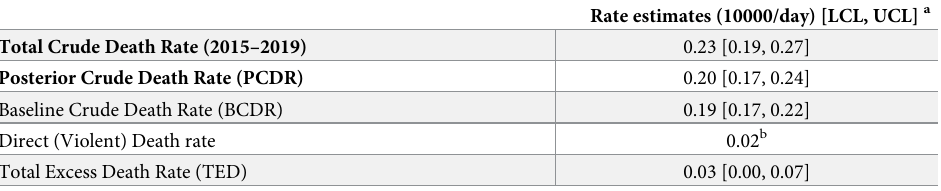
Table 2. Excess death rate estimates using baselines and conflict period CE-DAT surveys, Yemen,